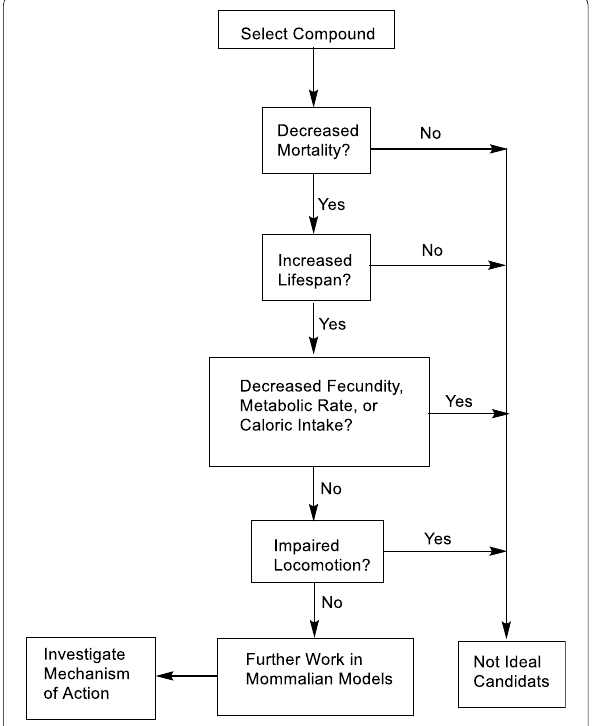
Fig. 1 Proposed algorithm to screen antiaging